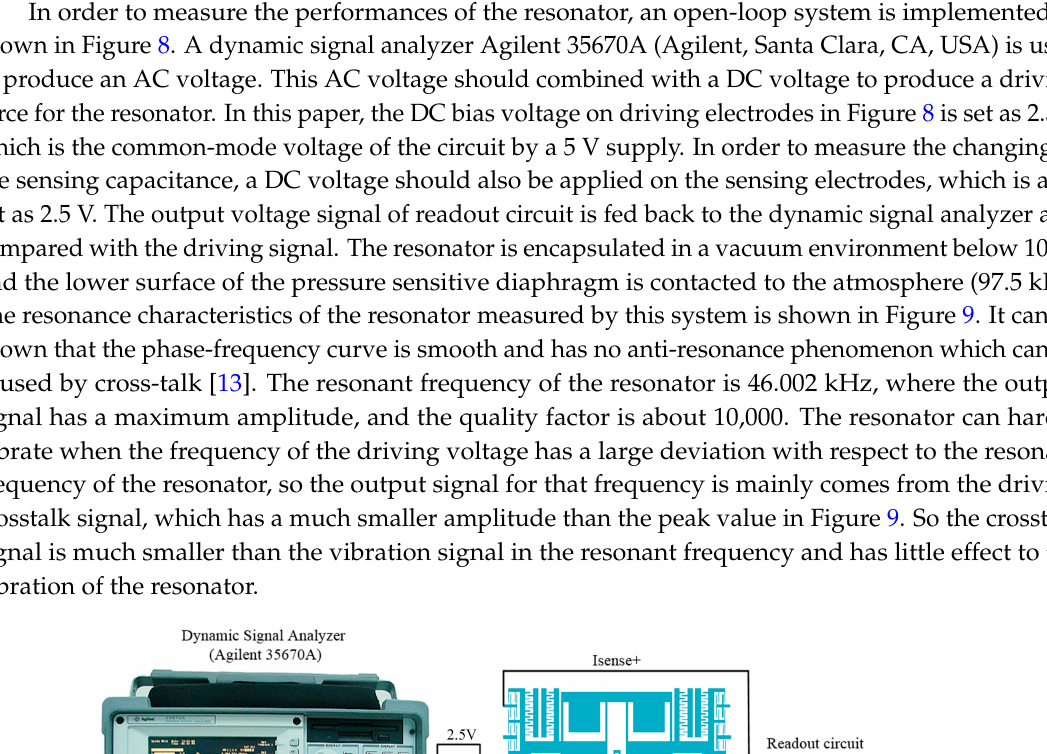
Figure 7. ( a ) The picture of the fabricated resonator; ( b ) The schematic drawing of the sensor package.